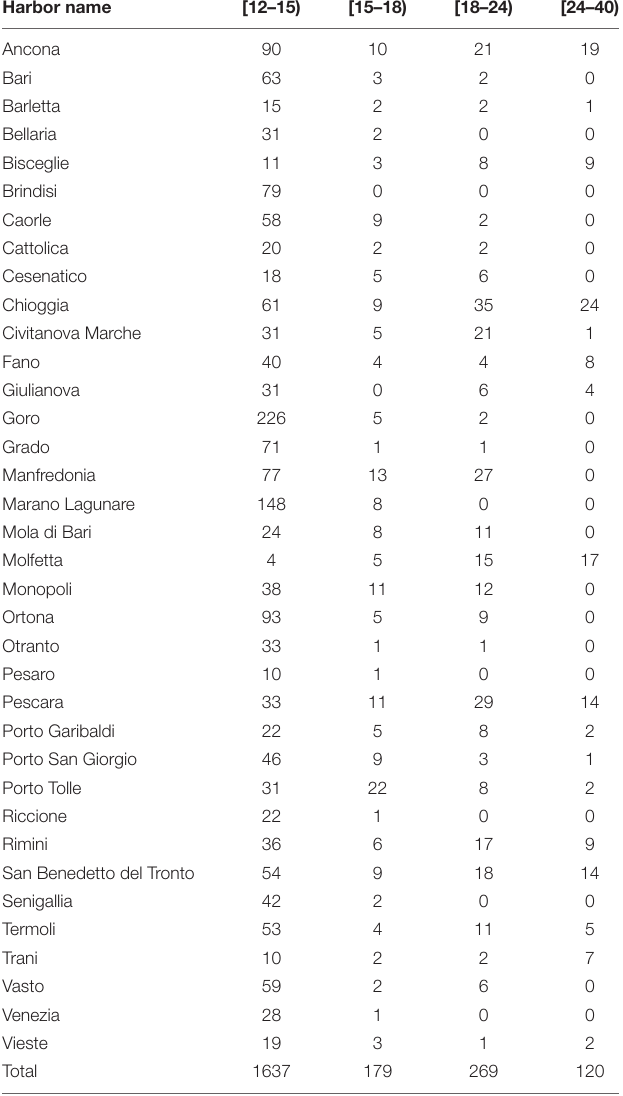
TABLE 2 | Number of trawlers for each Italian harbor along the Adriatic coast and for each length class according to the DCF. Harbor